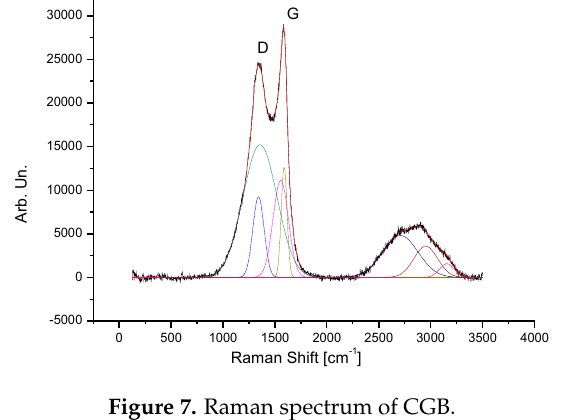
Figure 7. Raman spectrum of CGB. Table 1. Decomposition of peaks in Raman spectrum of CGB.